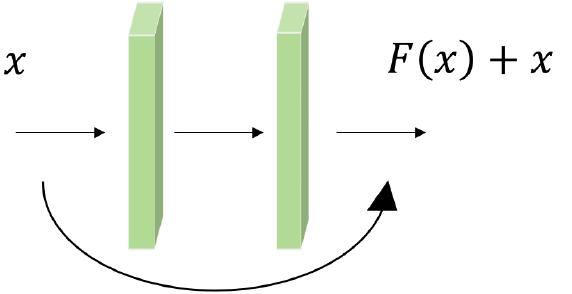
Figure 3. Residual